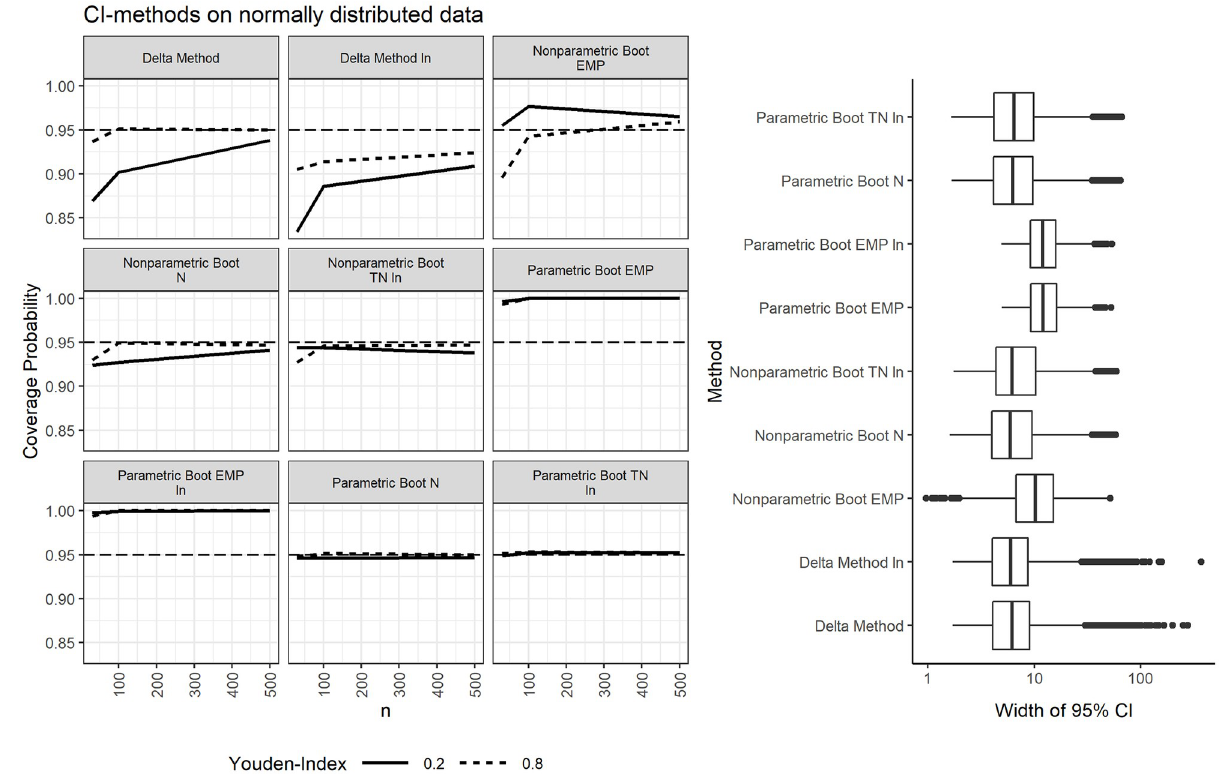
Fig 1. Coverage probabilities and widths of 95% confidence intervals for the optimal cutpoints on normally distributed data.